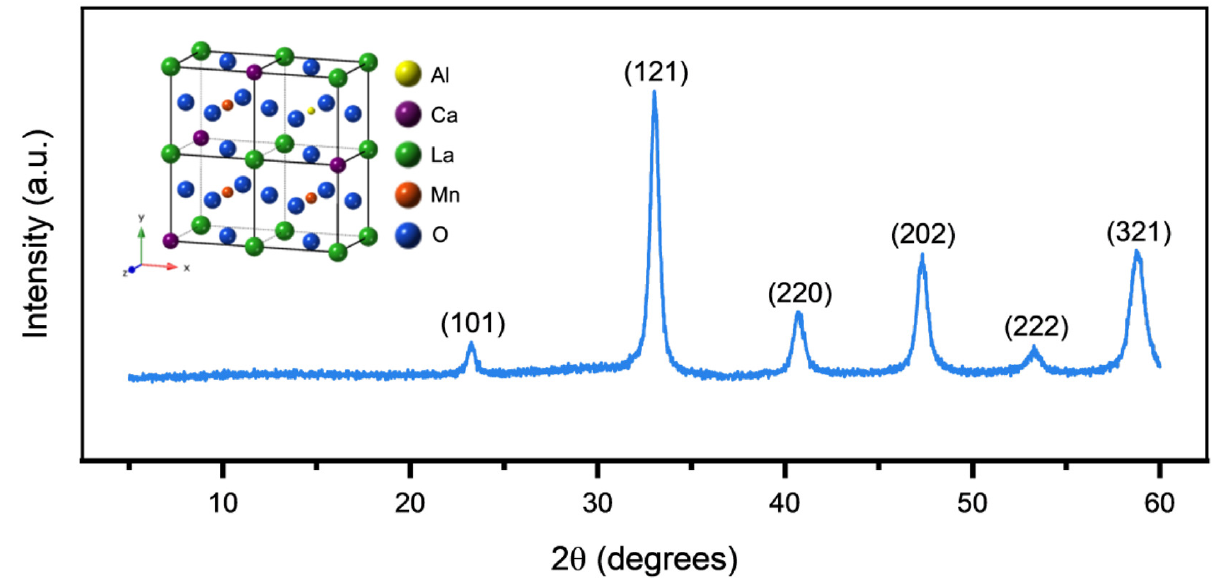
Figure 8. XRD pattern of the calcined LCMA powder displaying phase pure powder in the perovskite structure.